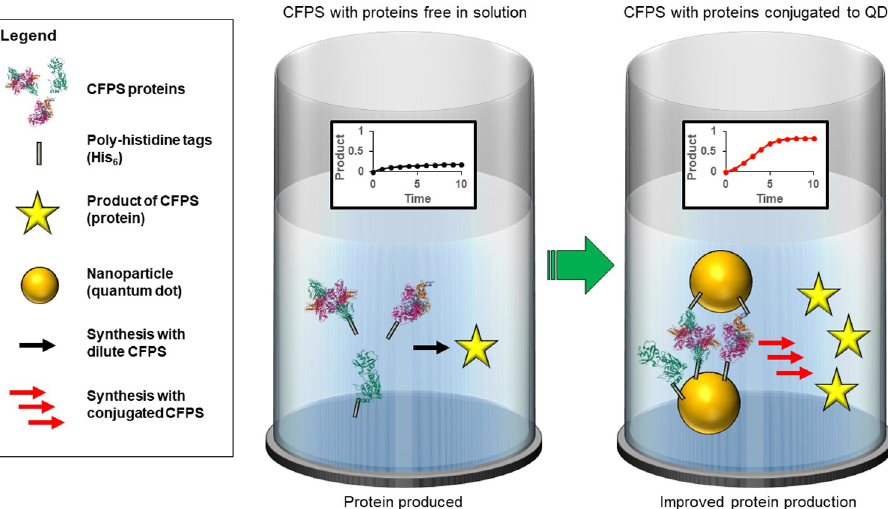
Fig 1. Schematic depicting enhanced cell-free protein synthesis from aggregating the intrinsic enzymes around NPs. (CFPS) systems can suffer from limited reaction rates, likely due to diffusion between components as shown in the reaction to left. CdSe/ZnS core/shell quantum dots (QDs) bind the His-tag of some CFPS components and cross- link into NP-aggregates to bring them into proximity, potentially increasing the catalytic rates or product yield. The enzyme structures shown are known to be present in the CFPS utilized and are represented by structures drawn from the PDB. IDs: 1CRK (mitochondrial creatine kinase), 1FMT ( E . coli methionyl-tRNA(f)Met formyltransferase),